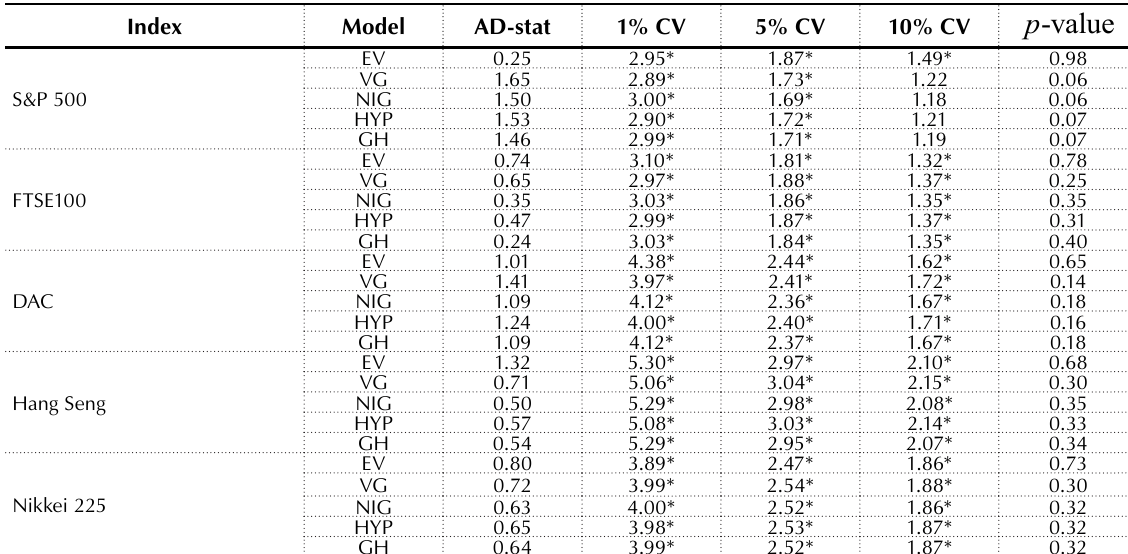
Table 3. Anderson-Darling and left-truncated Anderson-Darling goodness-of-fit